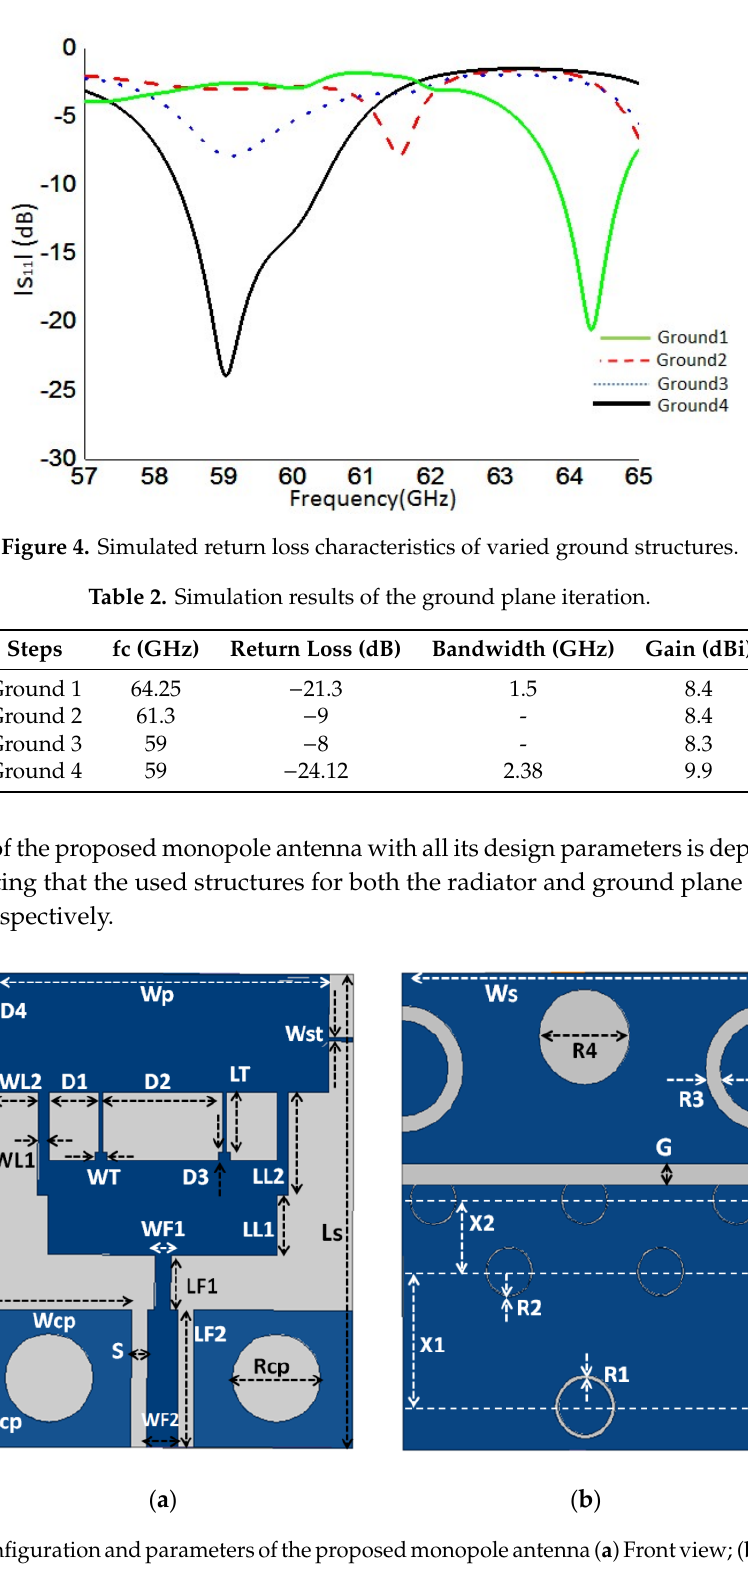
Figure 5. Configuration and parameters of the proposed monopole antenna ( a ) Front view; ( b ) Back view.